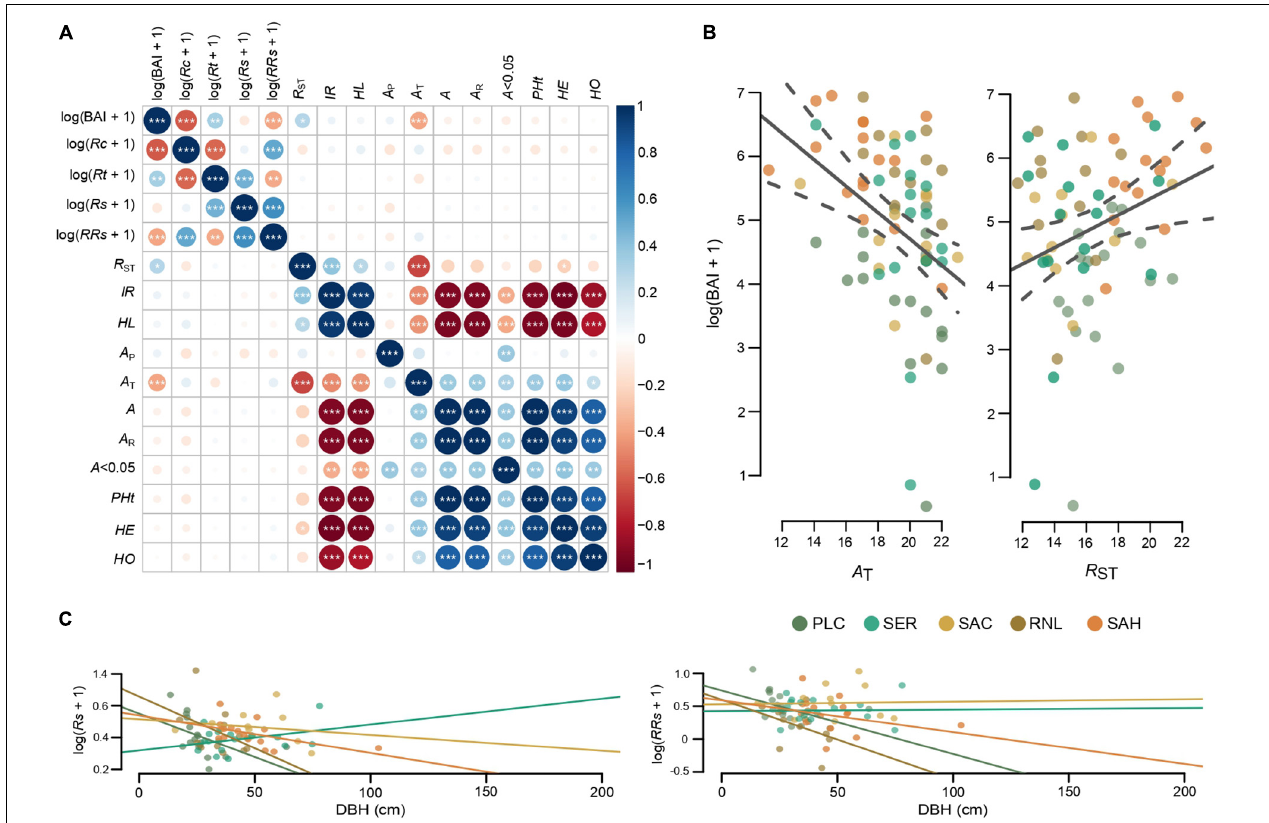
FIGURE 2 | (A) Correlation matrix among tree growth variables and genetic variables. (B) Linear relation between tree growth variables and alleles numbers and distance genetic. These two genetics variables are the ones that have the highest correlations with the tree growth in 1968. (C) Linear relation between resilience indices and